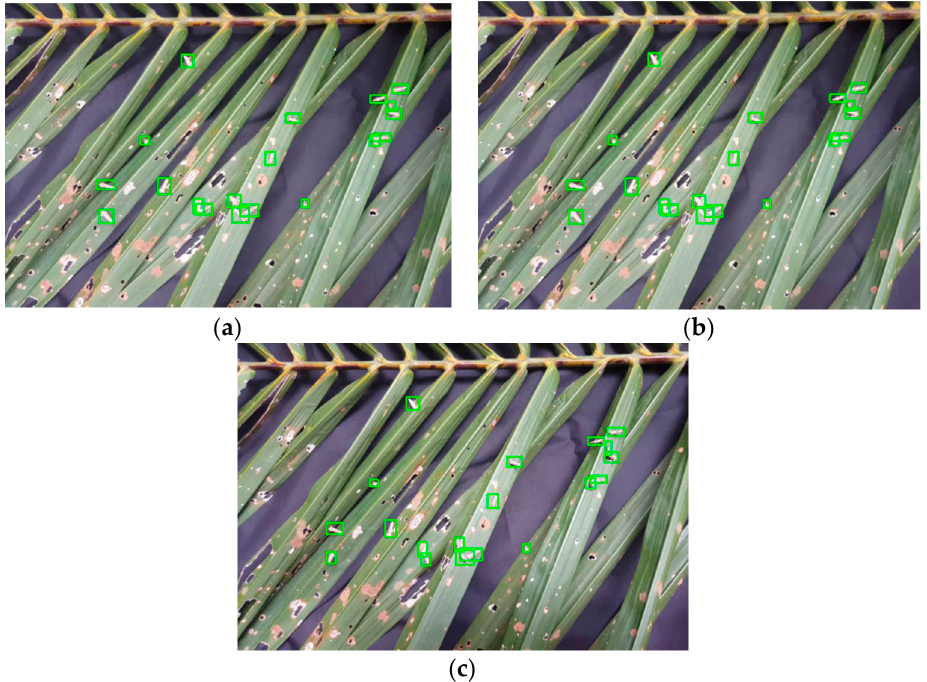
Figure 12. Detection based on 30 cm camera distance through DL with controlled conditions: ( a ) open, ( b ) closed and ( c ) half-open areas.